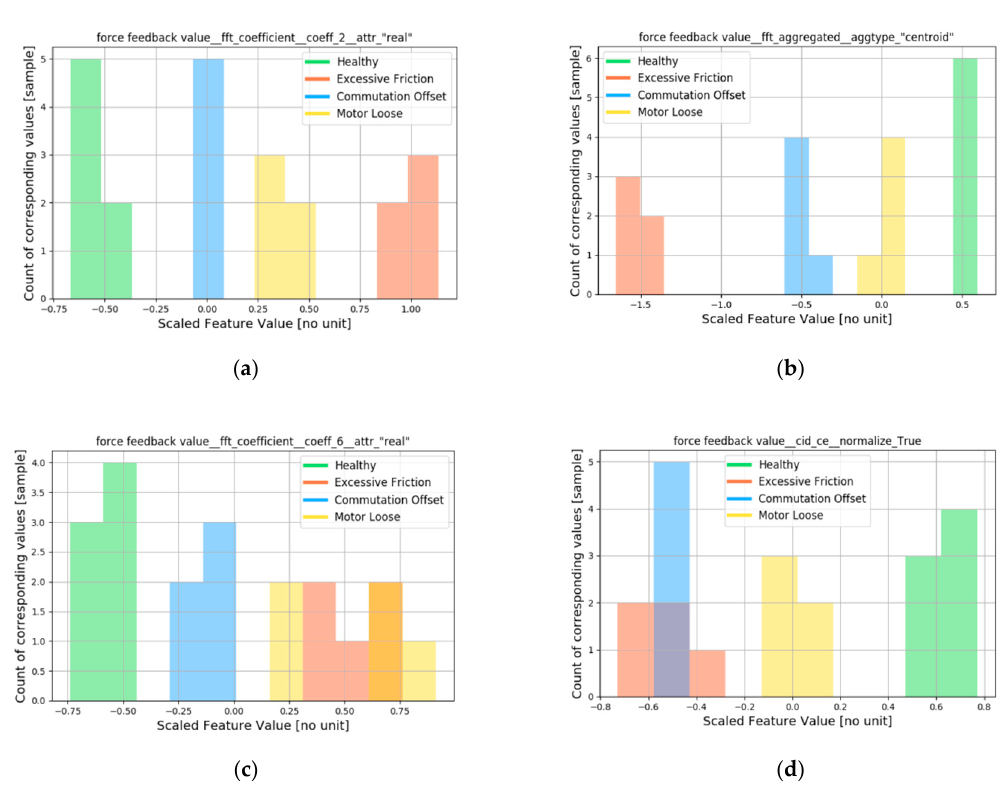
Figure 4. Examples of extracted and filtered features of ROI 2, in which the upper row [( a ) and ( b )] display high quality features allowing to distinguish all different conditions, whereas the lower row [( c ) and ( d )] contains features that overlap for some conditions: ( a ) Fourier-transform type; ( b ) Fourier-transform type; ( c ) Fourier-transform type; ( d ) complexity-invariant distance (CID)